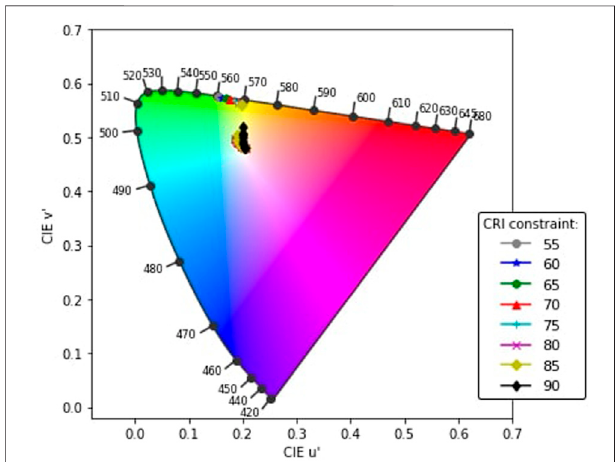
FIGURE 7 | u ’ and v ’ values on the CIE 1976 colorimetric diagram for all ray traced optimal